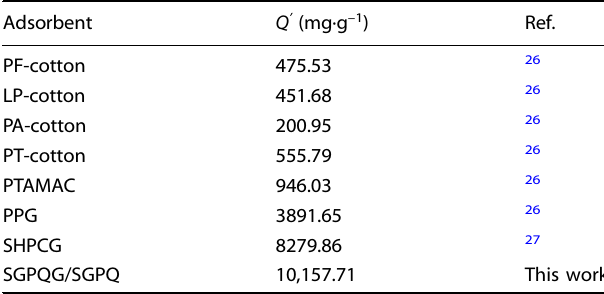
Table 1. Comparing the superiority of SGPQG/SGPQ with the serial existing materials for removing lignin from water*.